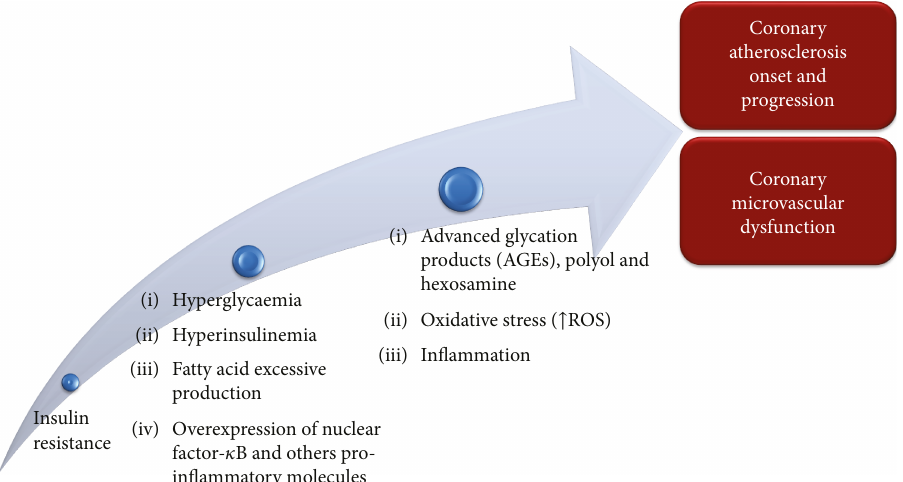
Figure 2: Pathophysiology of diabetes mellitus and its role in the determinism of